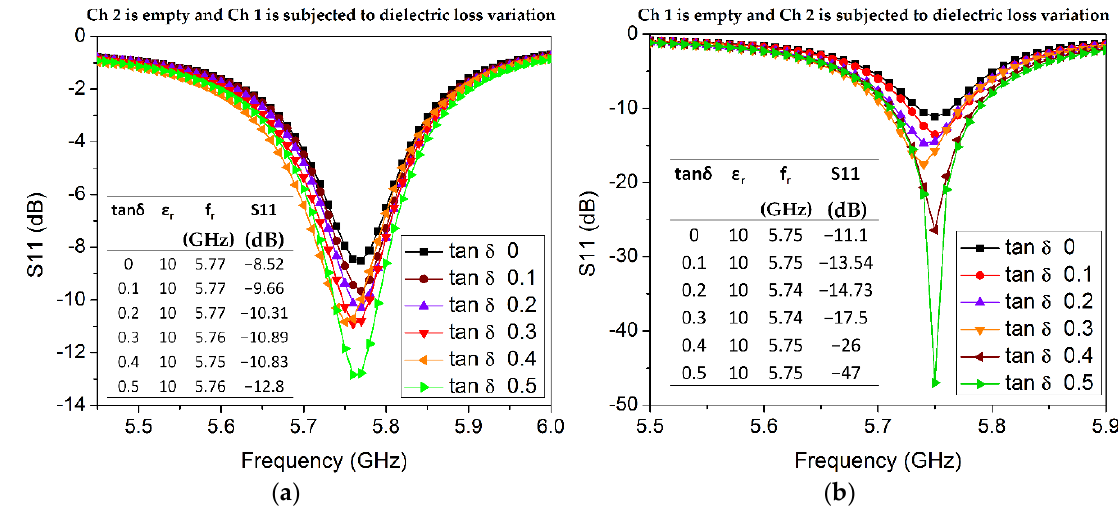
Figure 10. Effect of loss tangent variation of material inside the channel on the sensitivity of the proposed sensor. ( a ) Ch 2 is empty, and loss tangent variation in Ch 1 is analyzed. ( b ) Ch 1 is empty, and loss tangent variation in Ch 2 is analyzed. Permittivity is considered as a constant (ε r = 10) during these sets of simulations.